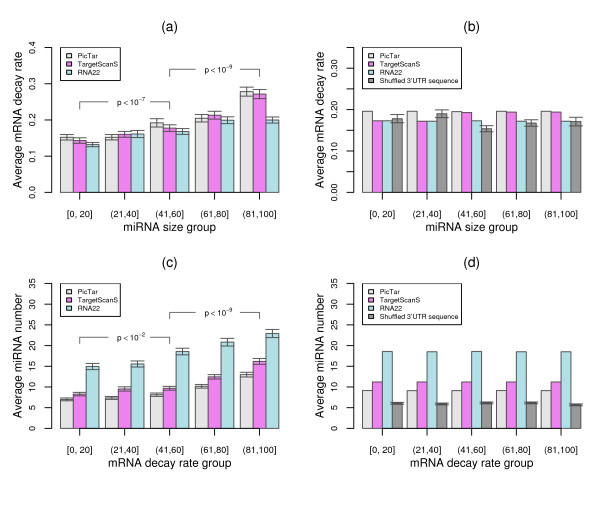
Relationship between the number of miRNA binding sites and mRNA decay rate. (a) Variation of mRNA decay rates for 5 miRNA binding site groups with increasing number of binding sites. The degree of the increasing trend for mRNA decay rates along with the increasing number of miRNA binding sites was estimated by Wilcoxon rank sum tests and depicted in p-values. (b) The expected variation of mRNA decay rates from both permutation tests and shuffled 3'UTR sequences for 5 miRNA binding site groups with increasing number of binding sites. (c) Variation of miRNA binding site number for 5 mRNA decay rate groups with increasing decay rates. The degree of the increasing trend for miRNA binding site number along with the increasing mRNA decay rates was estimated by Wilcoxon rank sum tests and depicted in p-values. (d) The expected variation of miRNA binding site number from both permutation tests and shuffled 3'UTR sequences for 5 mRNA decay rate groups with increasing decay rates.